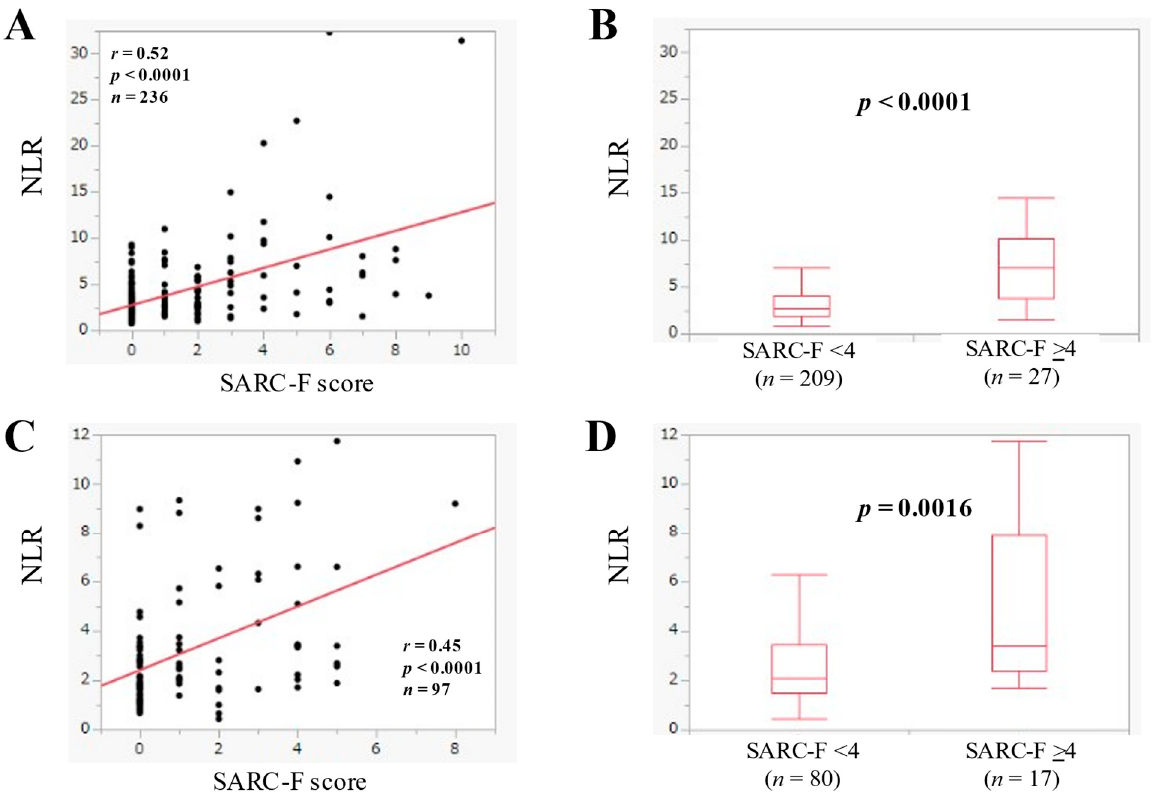
Figure 4. ( A ) The relevance in the NLR and the SARC-F score in BP-D cases ( n = 236). ( B ) Comparison of NLR between SARC-F <4 ( n = 209) and ≥ 4 ( n = 27) in BP-D cases. ( C ) The relevance in the NLR and the SARC-F score in L-D cases ( n = 97). ( D ) Comparison of NLR between SARC-F <4 ( n = 80) and ≥ 4 ( n = 17) in L-D cases.